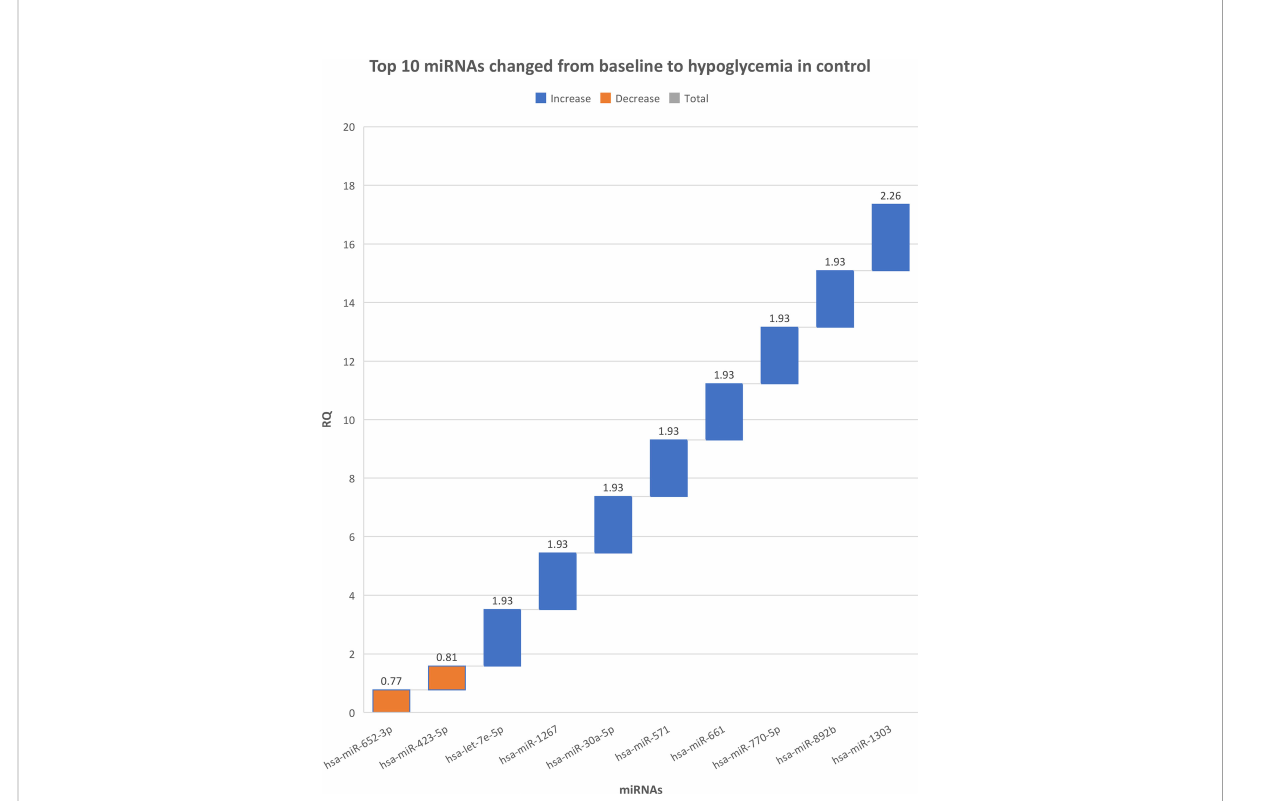
FIGURE 1 The top 10 miRNAs that changed from baseline to hypoglycemia in control subjects. RQ, mean relative quanti fi